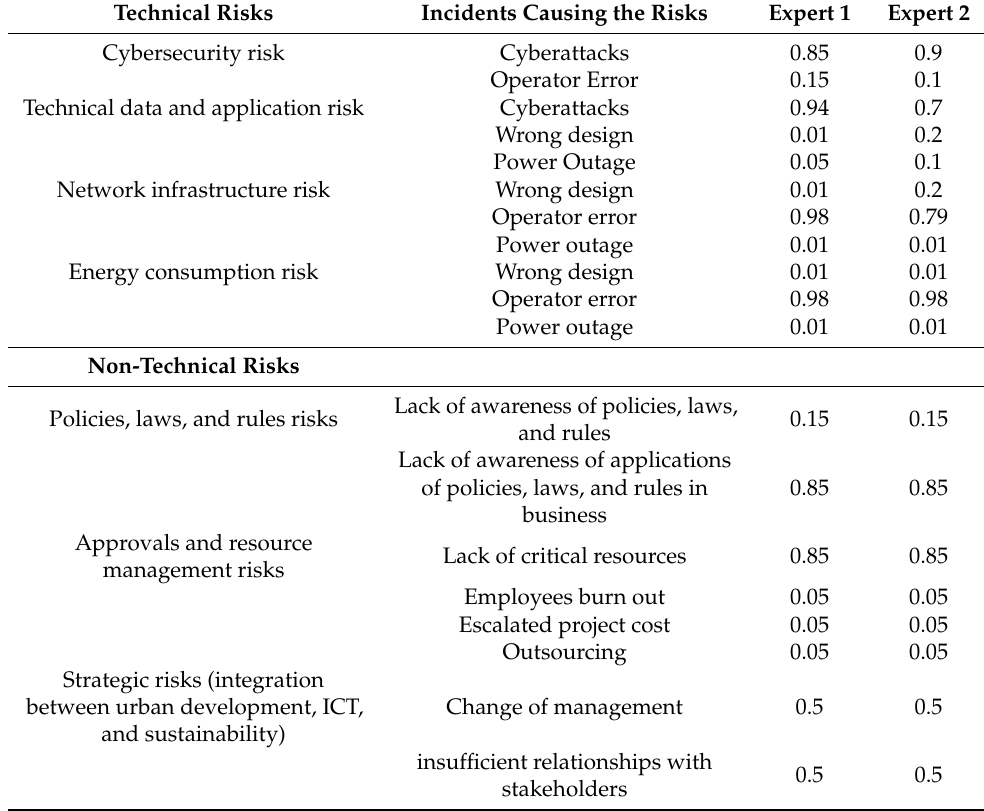
Table 3. The incidents causing risks and experts’